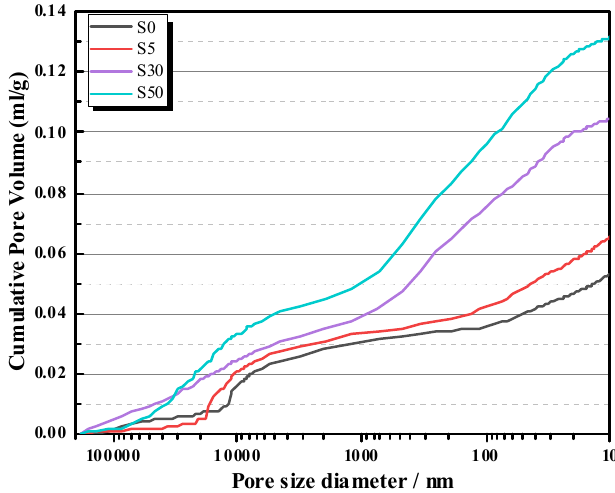
Figure 7. MIP of AAS mortars at 28 days.